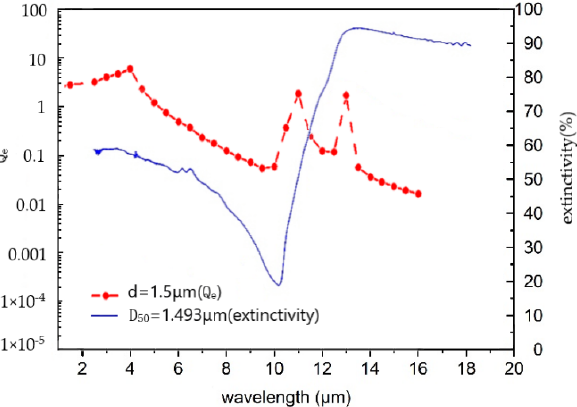
Figure 14. Comparison between the simulation results of the spectral extinction factor of the SiC elementary particles and the test results of the spectral extinction performance of sample